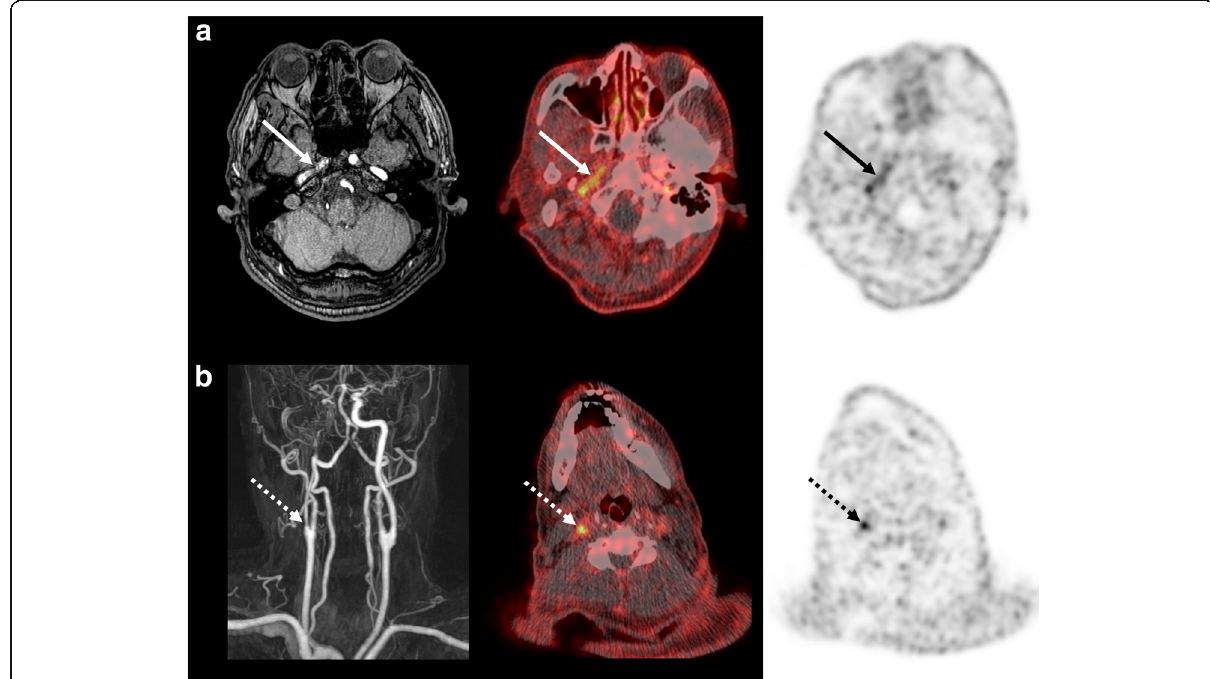
Fig. 3 18 F-GP1 PET/CT and magnetic resonance images of a 61-year-old man with acute cerebral infarction in the right middle cerebral artery territory and basal ganglia. Transaxial images of 18 F-GP1 PET/CT at 60 min after injection show increased uptake in the petrous part of the right internal carotid artery ( a , arrows) and right proximal internal carotid artery ( b , dotted arrows). Magnetic resonance images reveal filling defects in right internal carotid artery ( a , b ). A smooth echogenic plaque was seen from the bilateral carotid bulbs to the proximal internal carotid arteries on transcranial Doppler (large-artery atherosclerosis